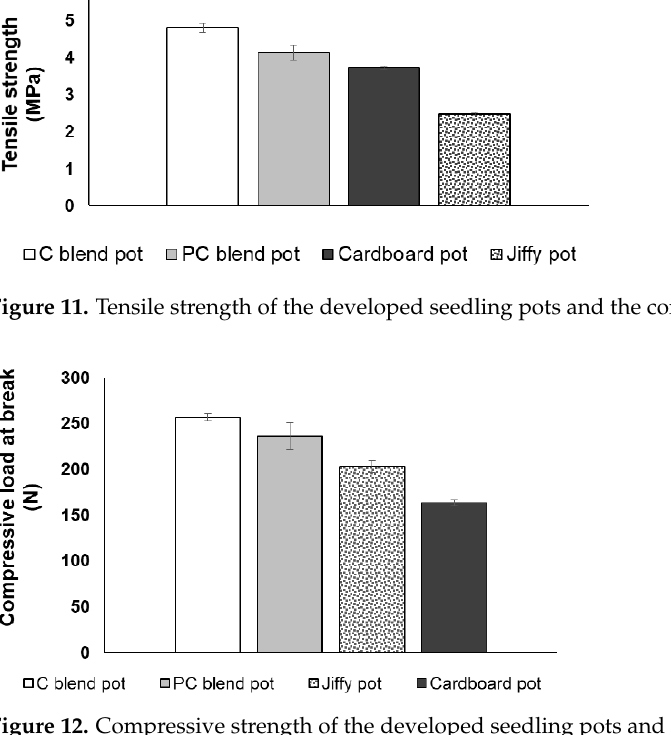
Figure 12. Compressive strength of the developed seedling pots and the commercial pots.